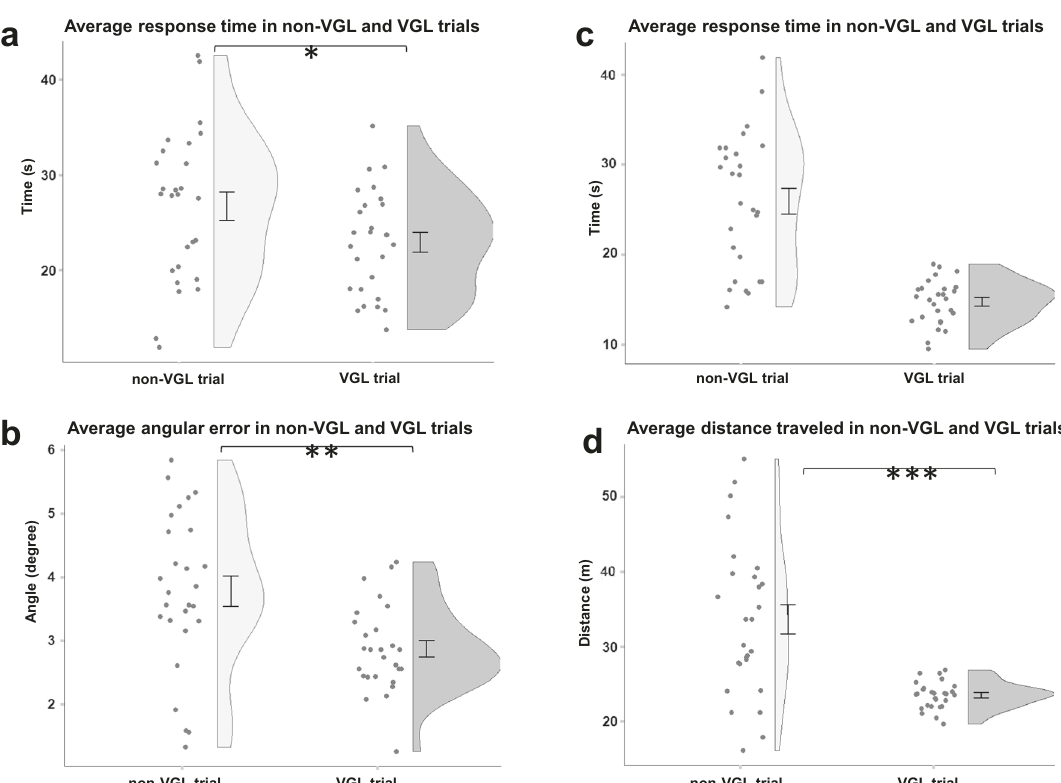
Fig. 2 Behavioural results from the way fi nding and pointing tasks: with and without global landmarks visible. Each dot of the scatter plot indicates the average value for one subject. The results of the pointing task: a Average response time in seconds; and b Average angular error. The results of the way fi nding task: c Average response time; and d Average distance travelled. The black dots represent means, and the error bars indicate standard errors. * p < 0.05, ** p < 0.01, *** p <